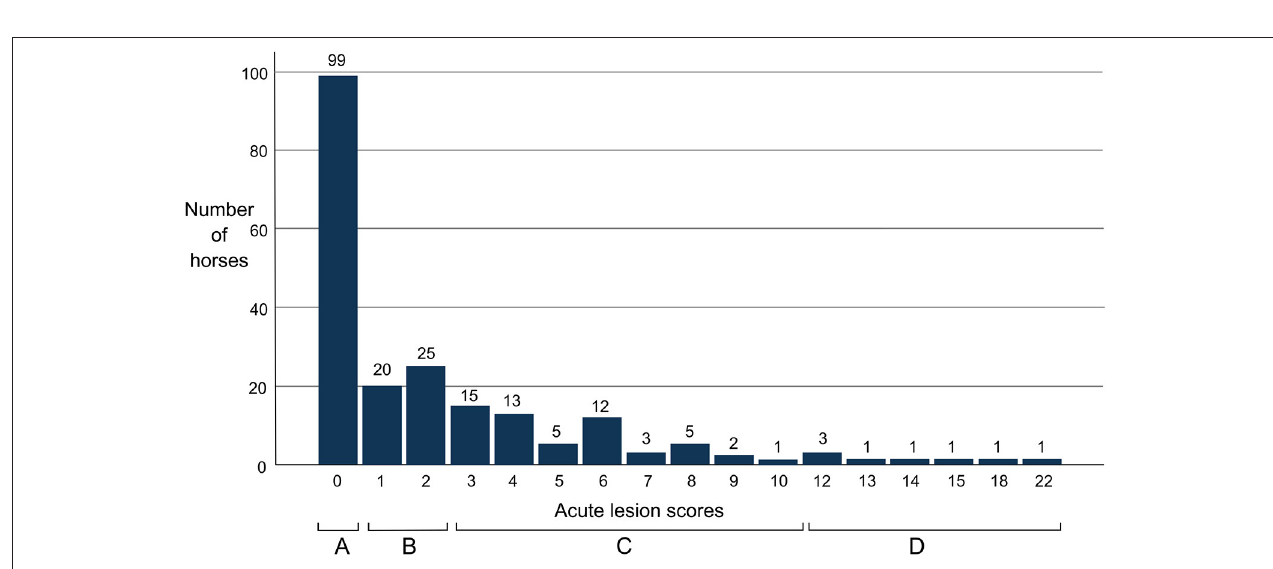
FIGURE 6 | Acute lesion scores (total lesion points) and lesion severity status for event horses ( N = 208) after a cross-country test.